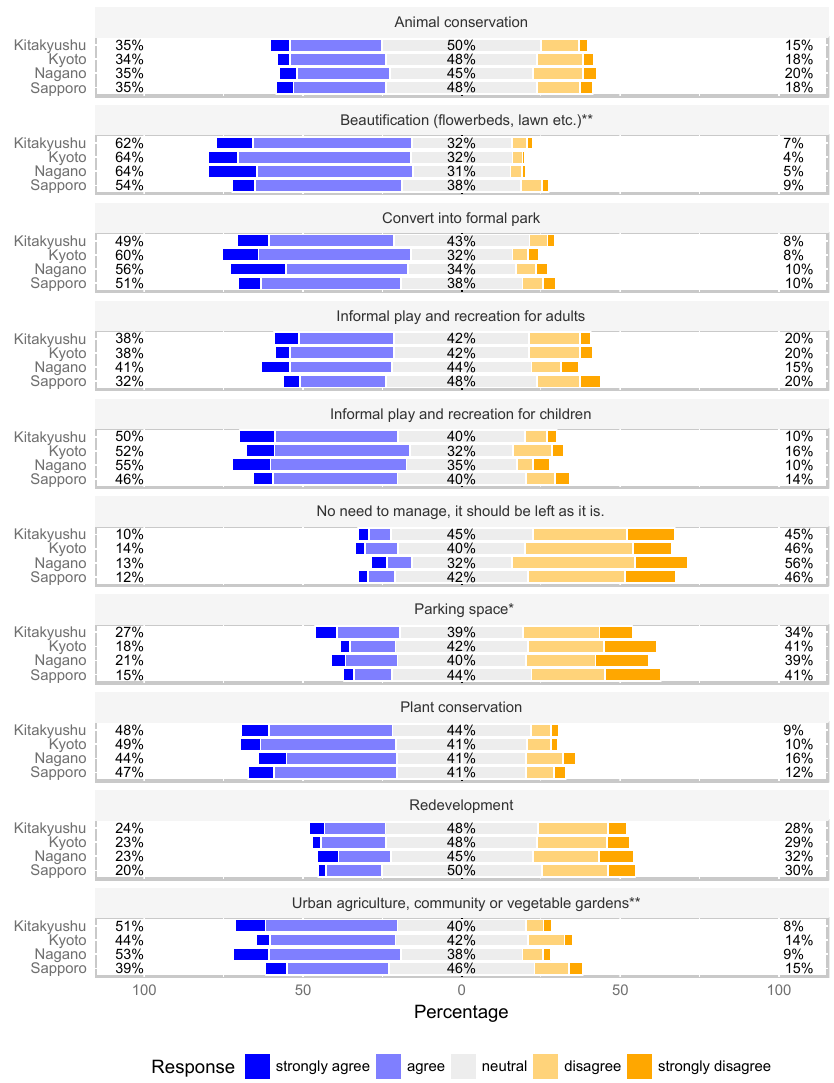
Figure 7. Respondents’ preferred management goals for IGS. Significant differences between the four cities are noted as * ( p < 0.05) and ** ( p < 0.01).